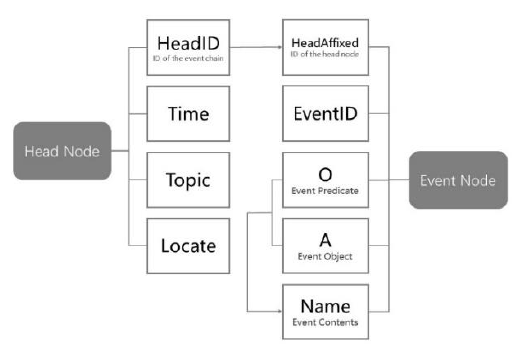
Figure 4 . Event storage